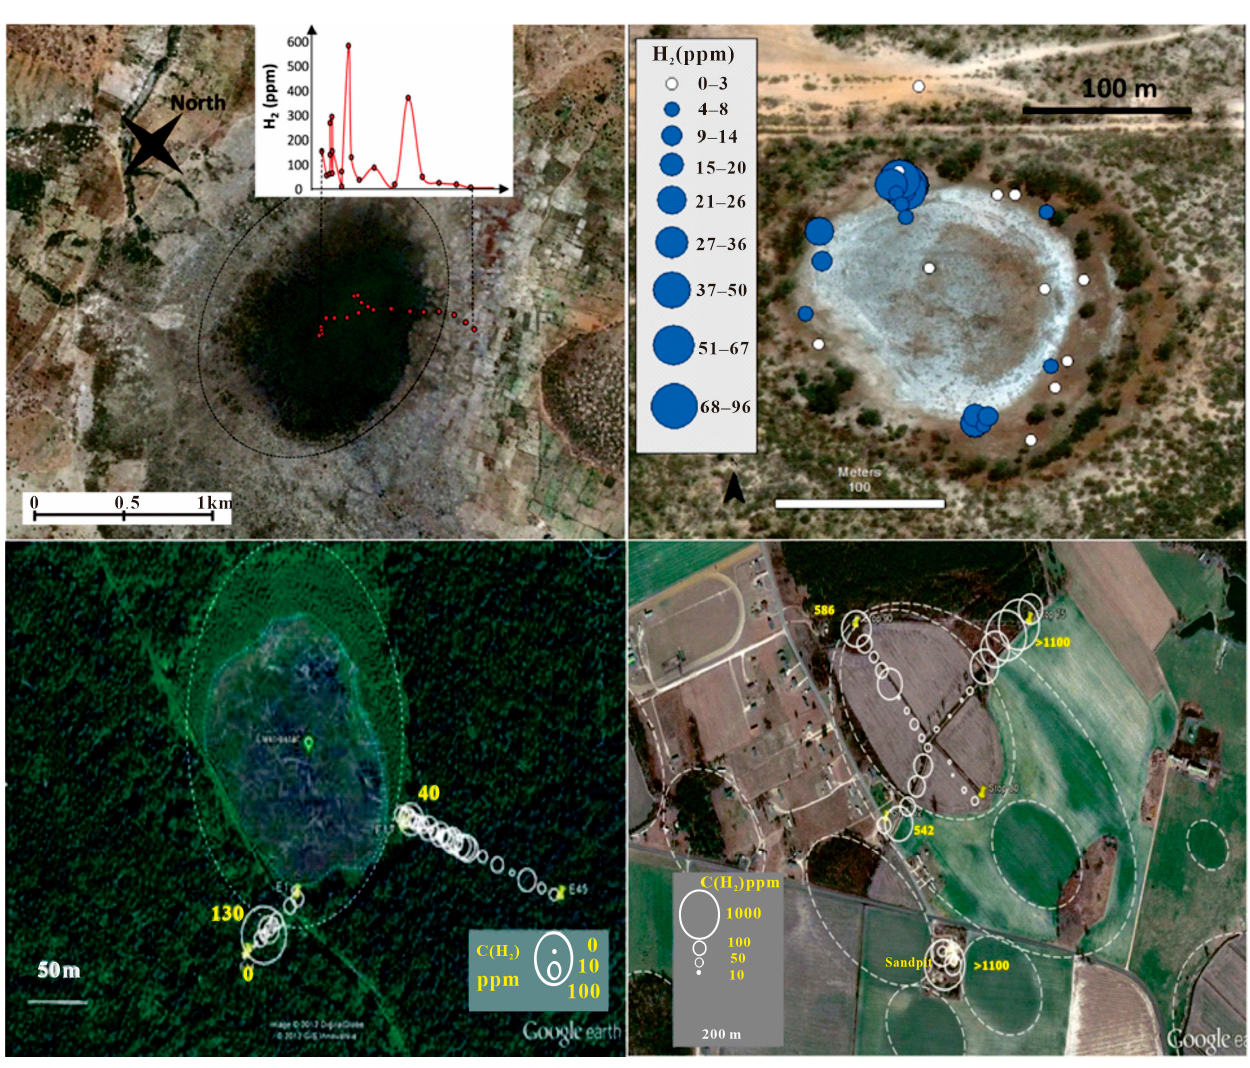
Figure 4. Fairy circles from Mali, Australia, Russia and the United States. ( Upper Left ) A large accumulation of natural hydrogen in Bourakebougou (Mali); ( Upper Right ) natural hydrogen seeps identified in the North Perth Basin, Western Australia; ( Lower Left ) natural molecular hydrogen seepage associated with Surficial, rounded depressions on the European Craton in Russia; ( Lower Right ) evidence for natural molecular hydrogen seepage associated with Carolina bays (surficial, ovoid depressions on the Atlantic Coastal Plain, in the USA).